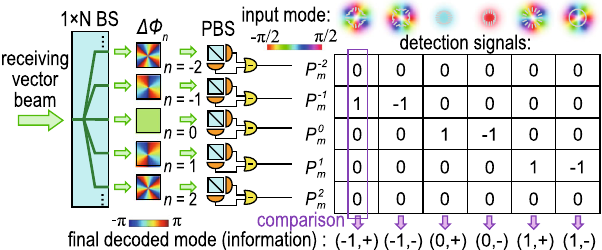
Fig. 2 The principle of signal detection. The incoming optical signal is split into N copies, each passing through an n th order polarization-dependent, decoding phase mask before the differential power between H and V polarization is measured. Here, the color represents the differential phase pro fi le of each decoding mask. All N decoded signals are then compared to determine the fi nal detected information level (vector beam modes). The table on the right shows the detected signals of fi ve decoding channels for six input modes (shown on the top with the color representing the polarization orientation), and the fi nal decoded information level at the bottom.